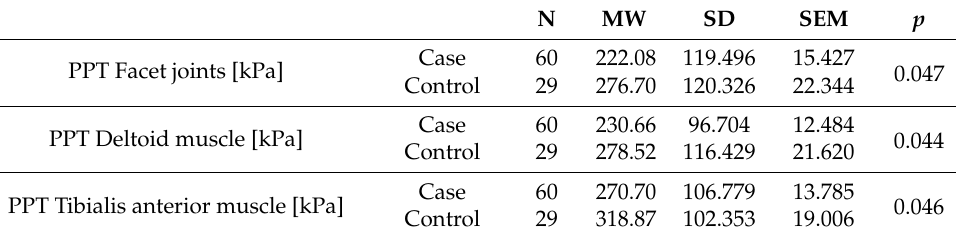
Table 3. Pain pressure thresholds case/control group